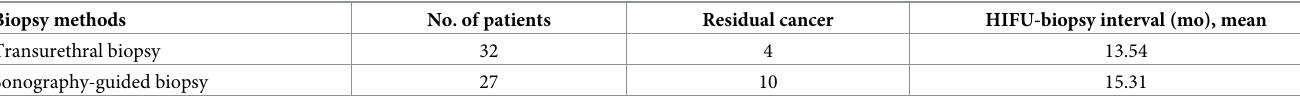
Table 4. Results of post-HIFU prostate biopsy.